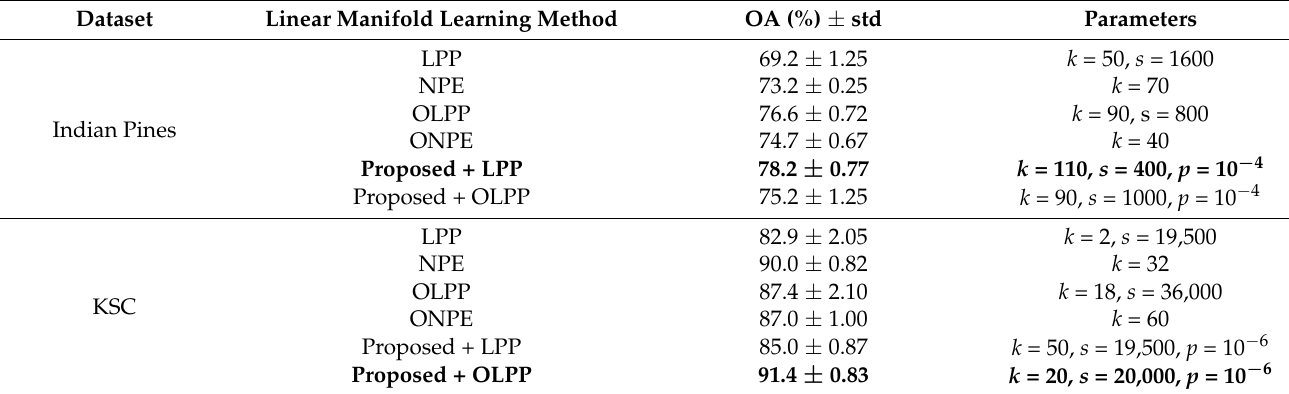
Table 2. Classification performance on linear manifold learning methods for the HSI datasets. (OA, overall classification accuracy in percentage; std, standard deviation; k , neighborhood; s , heat kernel parameter; the algorithm with the best performance is bolded for every dataset).